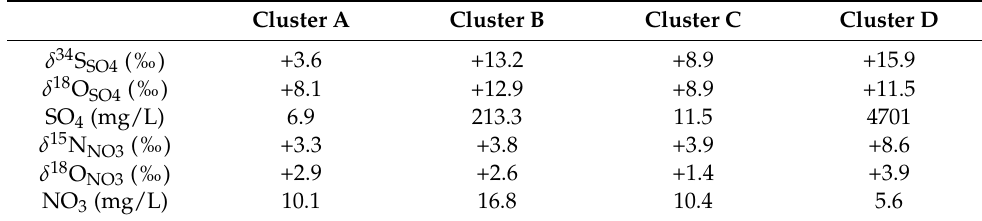
Table 3. Mean δ 34 S SO4 , δ 18 O SO4 , δ 15 N NO3 , and δ 18 O NO3 isotopic content along with the sulfate and nitrate concentrations associated with the four GW clusters defined in the PCM. Cluster A Cluster B Cluster C Cluster D δ 34 S SO4 (‰) +3.6 +13.2 +8.9 +15.9 δ 18 O SO4 (‰) +8.1 +12.9 +8.9 +11.5 SO 4 (mg/L) 6.9